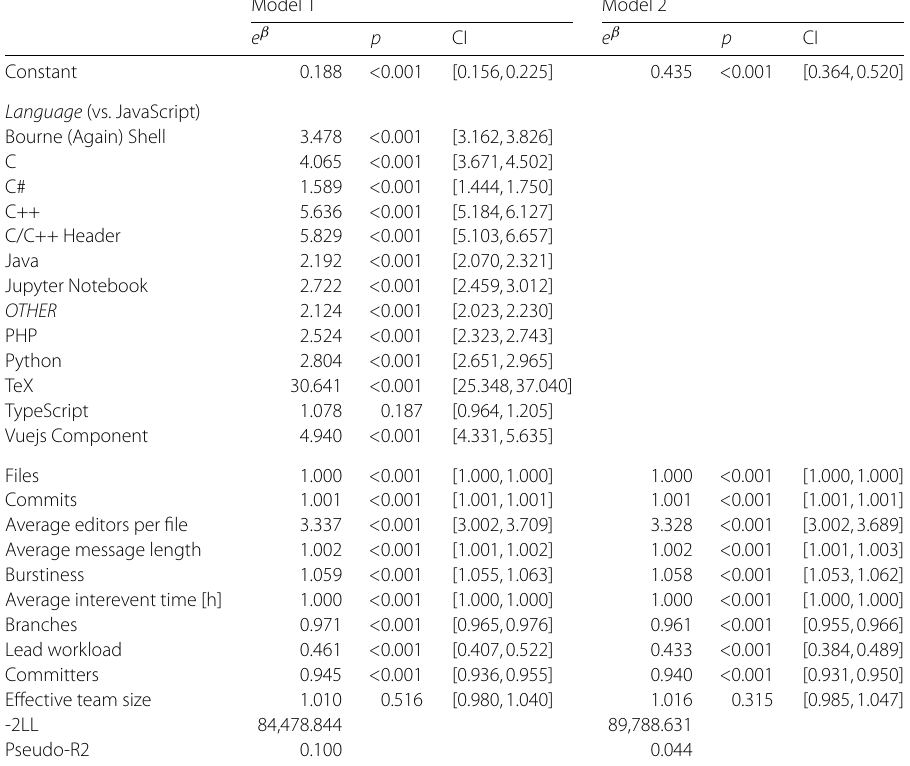
Table 3 Logistic regression models for GitHub vs. Penumbra outcome Model 1 Model